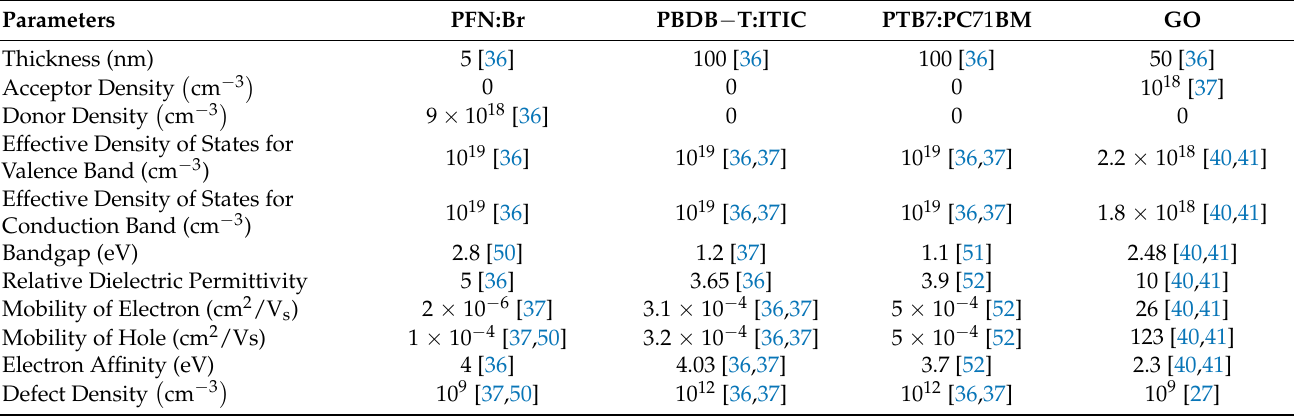
Table 1. Material parameters set in simulation.